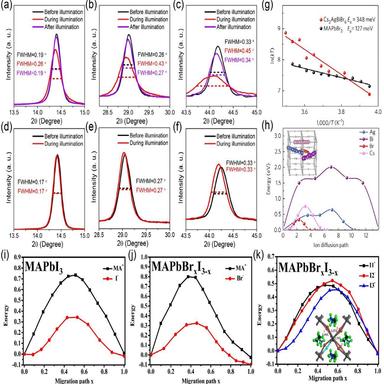
The XRD spectra of the MAPb(I0.6Br0.4)3 (a–c) and MAPb0.75Sn0.25(I0.6Br0.4)3 (d–f) perovskite films measured before, during, and after 10 min illumination. Copyright 2016, American Chemical Society. (g) Arrhenius plots of the temperature dependence of kT versus 1000/T. (h) Calculated energy profile along the ionic migration path for the possible ion vacancies in Cs2AgBiBr6. Inset: migration path of these ion vacancies. Copyright 2017, Springer Nature Limited. Energy profiles for